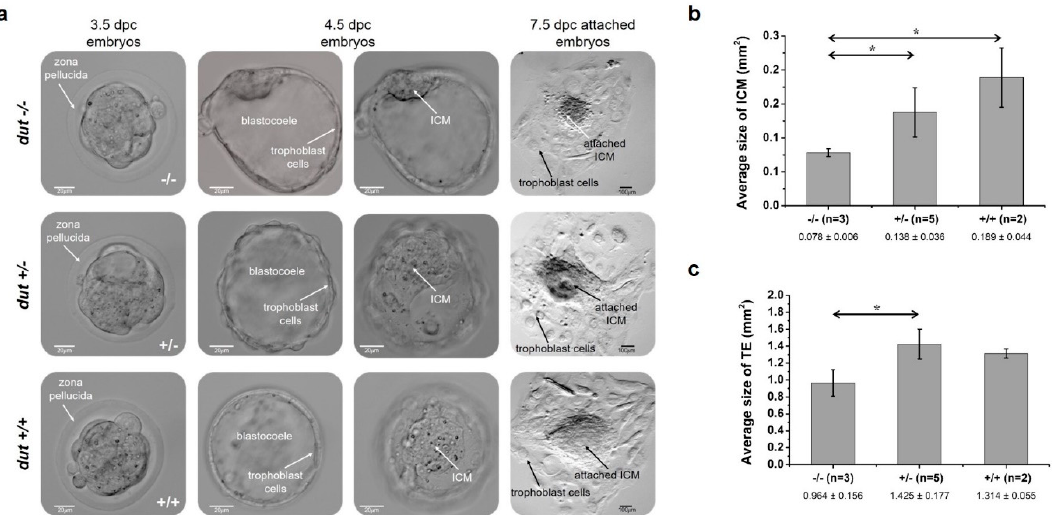
Figure 3. Outgrowth assay of pre-implantation embryos obtained by intercrossing D47 heterozygous